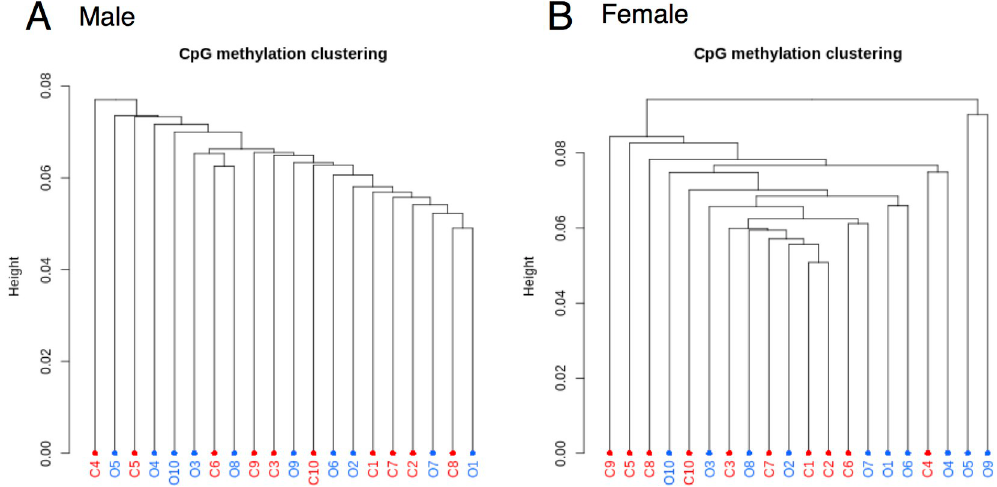
Fig 1. Hierarchical clustering of samples for males (A) and females (B) in the OBS discovery cohort. C: neonates of non- obese control mothers (n = 10/sex), O: neonates of mothers with obesity (n = 10/sex).